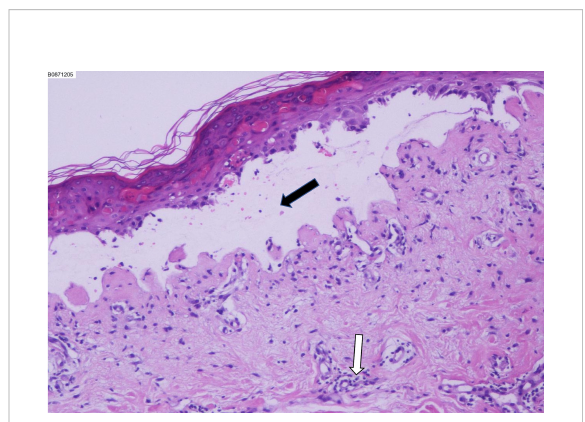
FIGURE 2 Biopsy of the skin lesion showing detachment of the epidermis and mucous membrane, which con fi rmed toxic epidermal necrolysis. Black arrow indicates subepidermal blisters. White arrow indicates perivascular lymphocytes accumulation.